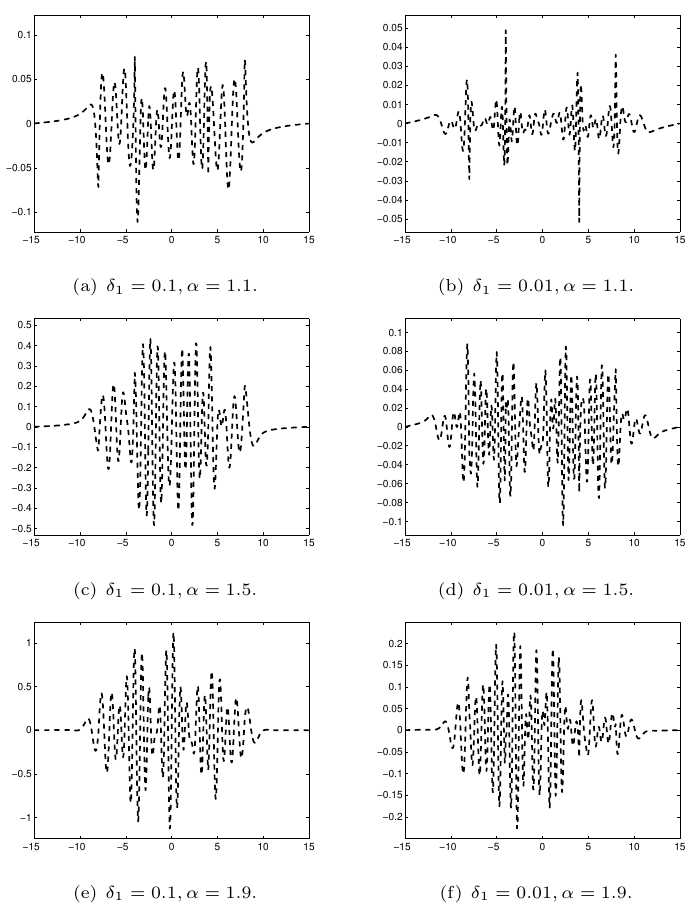
Figure 4. The error of the exact solution and its approximation (Example